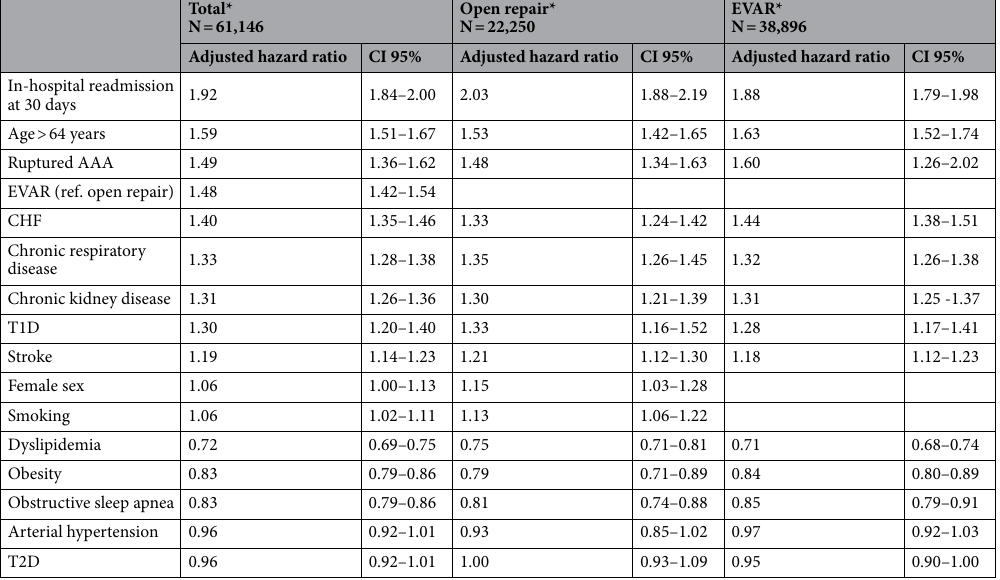
Table 3. Risk factors of in-hospital mortality after abdominal aortic aneurysm surgical repair. *Population of patients who had at least one follow-up i.e. admission at the hospital after the AAA surgical repair. Results are expressed as mean ± SD or n (%). AAA abdominal aortic aneurysm, CHF congestive heart failure, EVAR endovascular aneurysm repair, T2D type 2 diabetes, T1D type 1